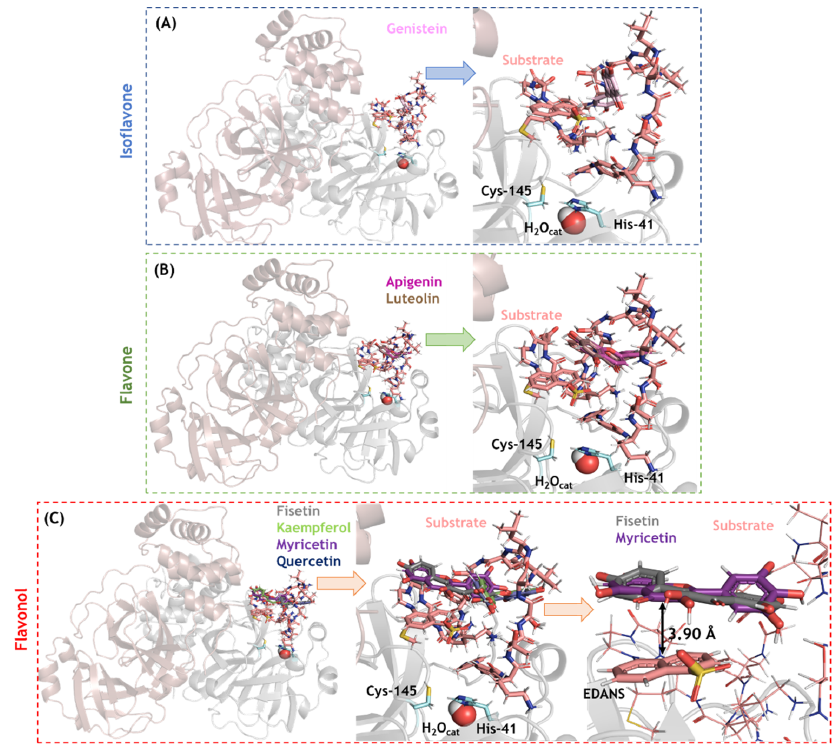
Figure 7. The 3D-representation of the best docking pose and the corresponding zoom representation for the flavonoids ( A ) isoflavone, ( B ) flavones, and ( C ) flavonols in the SARS-CoV-2 M pro active site in the presence of peptide substrate (CAS number 730985-86-1). Catalytic amino acid residues genistein, apigenin, luteolin, fisetin, kaempferol, myricetin, and quercetin are in stick representation in cyan, violet, pink, brown, gray, light green, purple, and marine, respectively. Catalytic water (H 2 O cat ) is shown in spherical configuration. Hydrogen, oxygen, and nitrogen are shown in white, red, and dark blue, respectively.